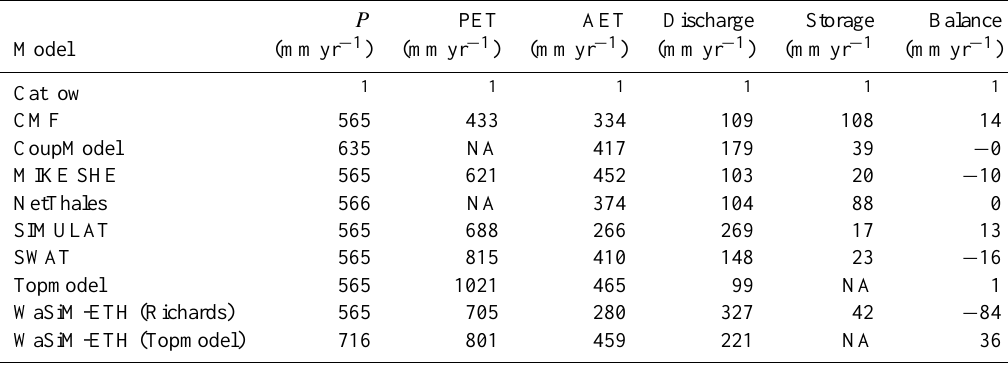
Table 8. Water budget components of the second year (second prediction) (NA: not available).